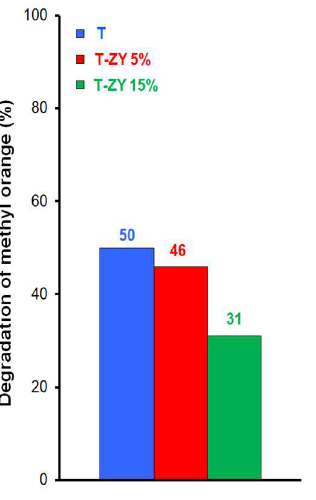
Figure 3. Degradation of methyl orange dye aqueous solutions after being UV irradiated for 2 h in